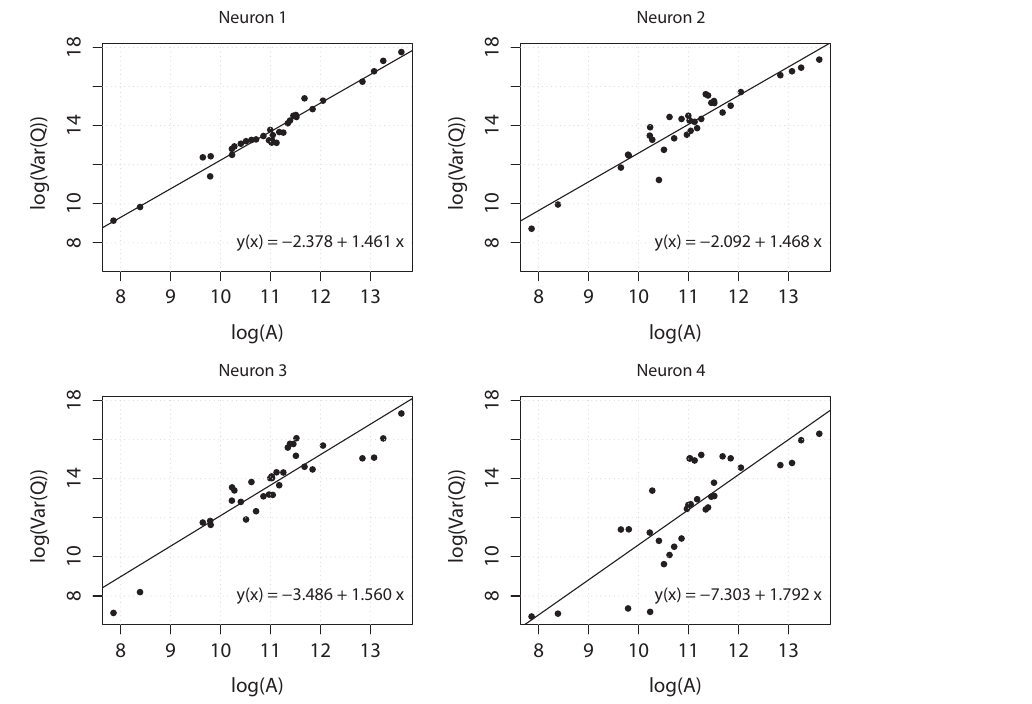
Figure 12. Scaling of variance of flood flow series in each neuron class. The least-square estimates of intercept and slope are shown in each panel. The black line shows the least-squares regression. Here Q represents the flood series while A represents the drainage area (km 2 ) of the respective catchment.